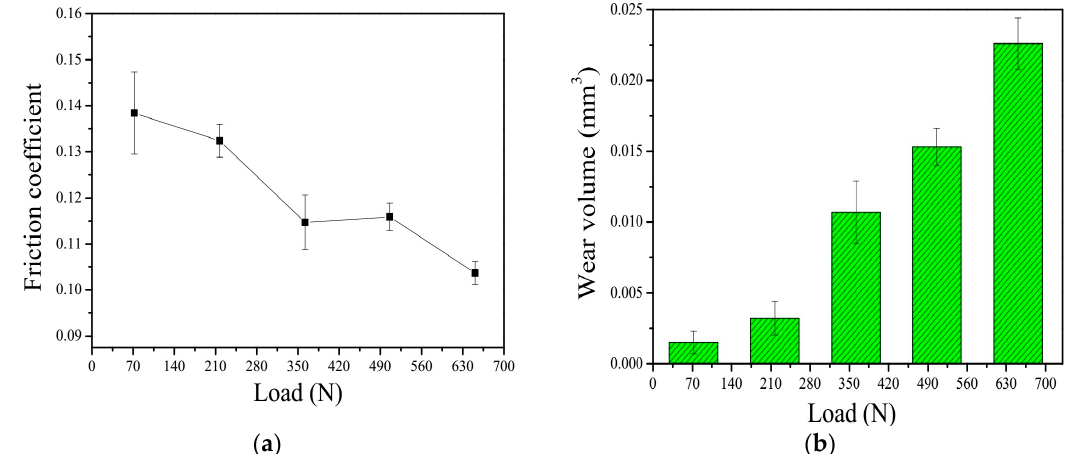
Figure 7. The change of friction coefficient and wear under different loads: ( a ) Friction coefficient vs. load; ( b ) wear volume vs. load.